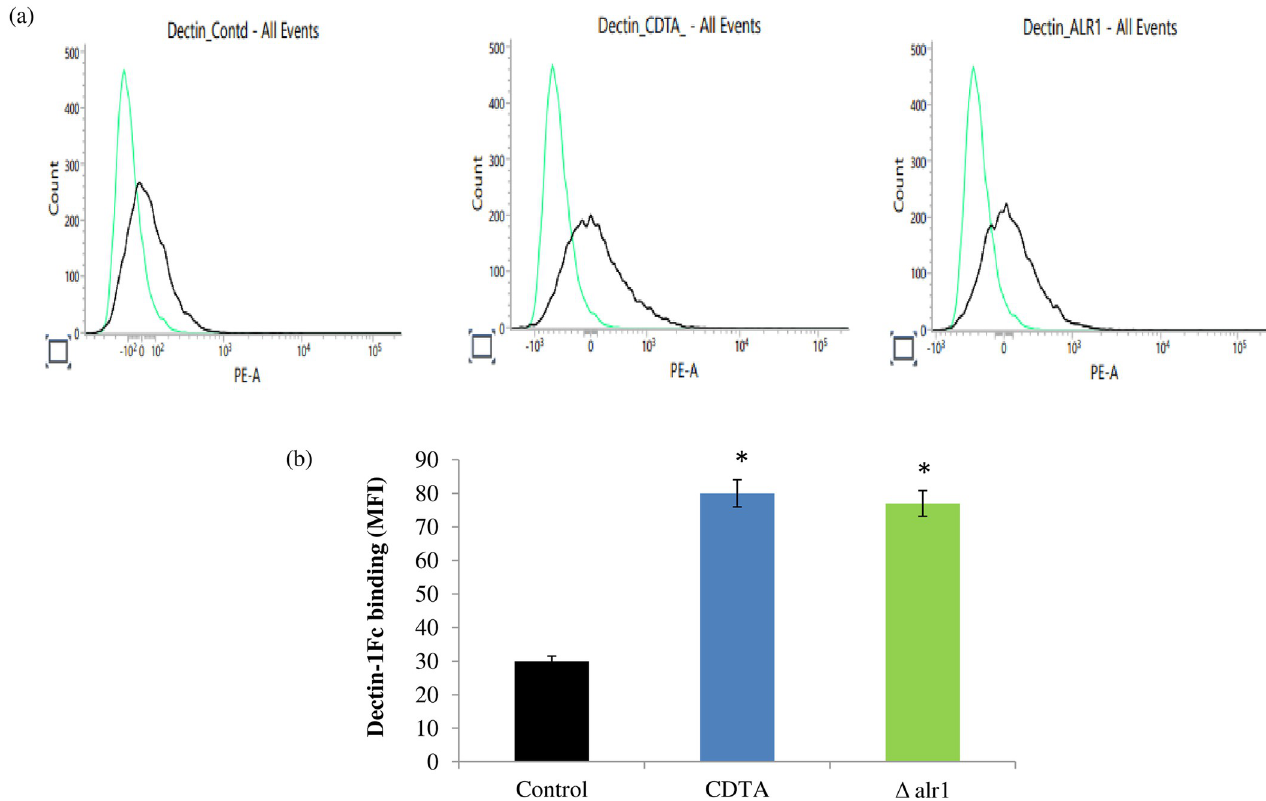
Fig 5. β -1,3 glucan exposure under Mg deprivation. ( a ) Representative flow cytometry plots display β 1,3-glucan exposure by dectin-1-Fc bindings in control, CDTA treated and Δ alr1 C . albicans . ( b ) Representative bar graphs depicting cumulative data of MFI of Dectin-1-Fc binding from 3 independent experiments.